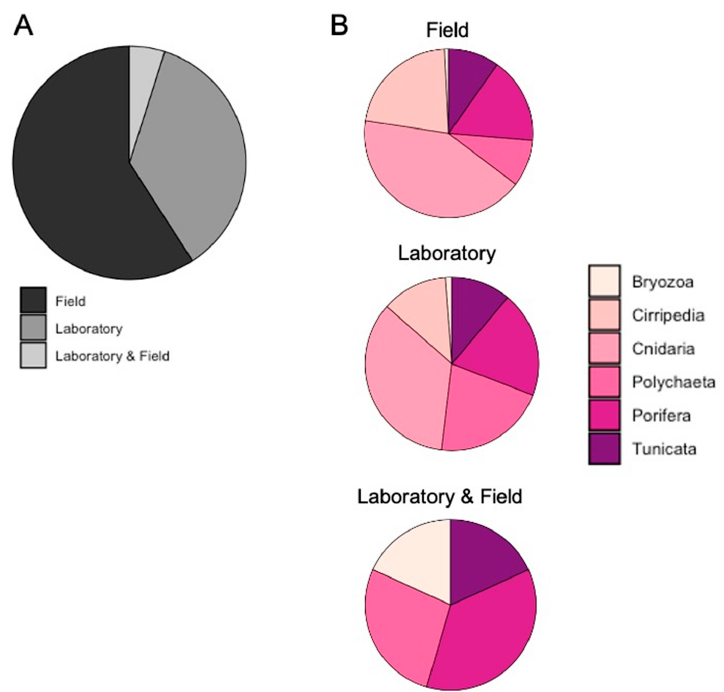
Figure 5. Percentage of documents per: ( A ) work setup and ( B ) taxa in each work setup.